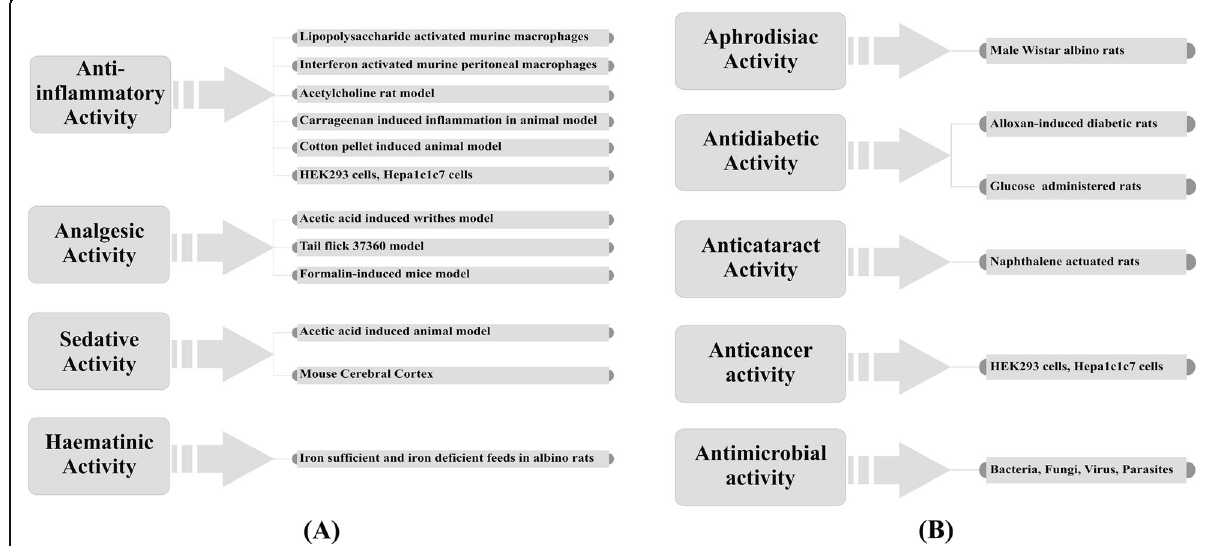
Fig. 3 a , b Therapeutic properties of W. indica and their study